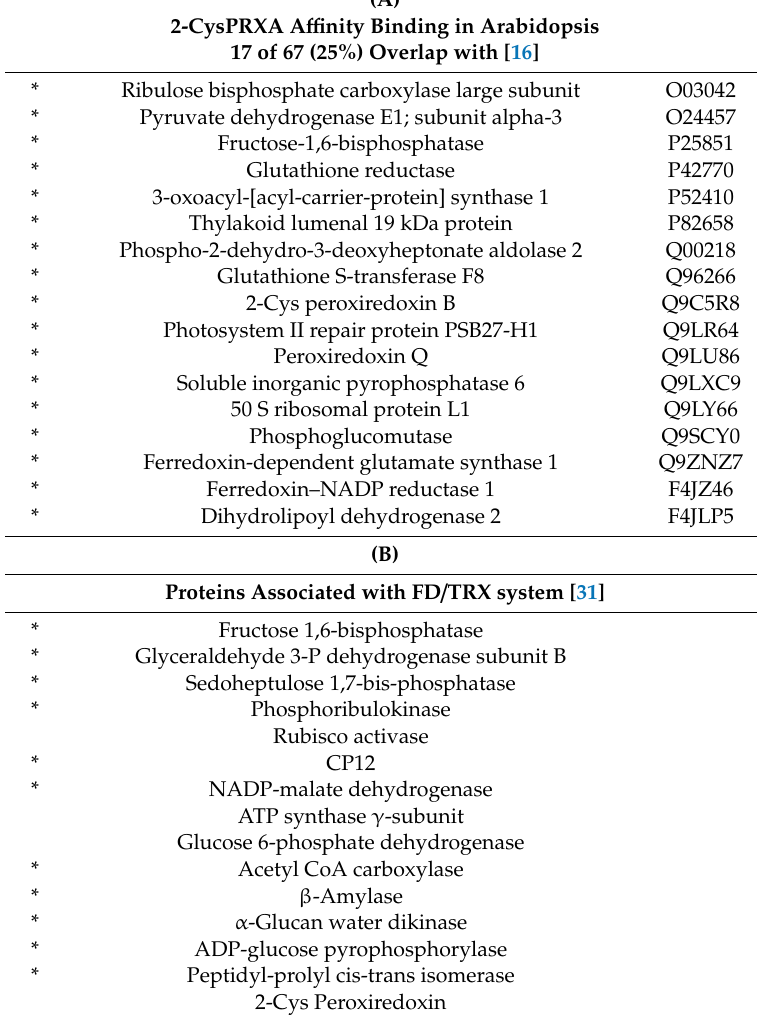
Table 2. Overlap between the results of this study and published redox proteomes. Overlap between polypeptides found in our study and ( A ) proteins identified in the 2-cysteine peroxiredoxin (2-CysPRX) interactome study of Cerveau et al. [16], ( B ) the ferredoxin (FDX)-thioredoxin (TRX) system [31], and ( C ) the TRX interactome as determined by TRX-trapping in spinach [29]. * = targets bound to 2-CysPRXA in this